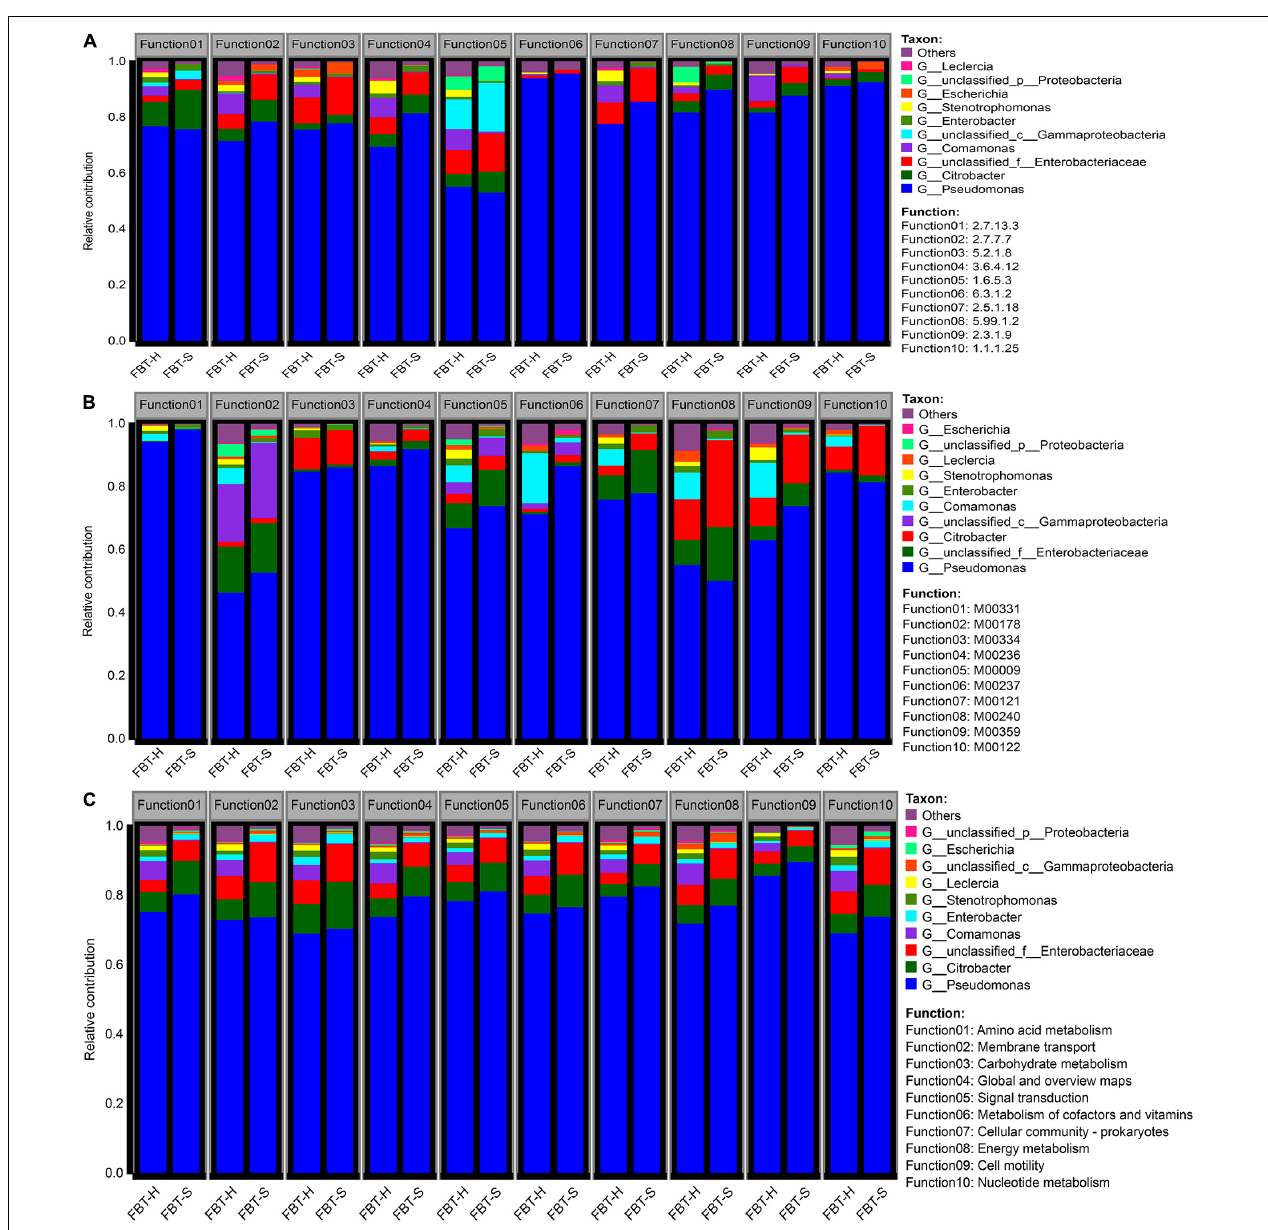
FIGURE 3 | Contribution of microbial populations to (A) enzyme functions, (B) functional modules, and (C) KEGG pathways. Colors indicate relative abundances of different taxa. The abundance contributed by taxa = (reads of the specific taxa associated with function)/(total reads of all taxa associated with